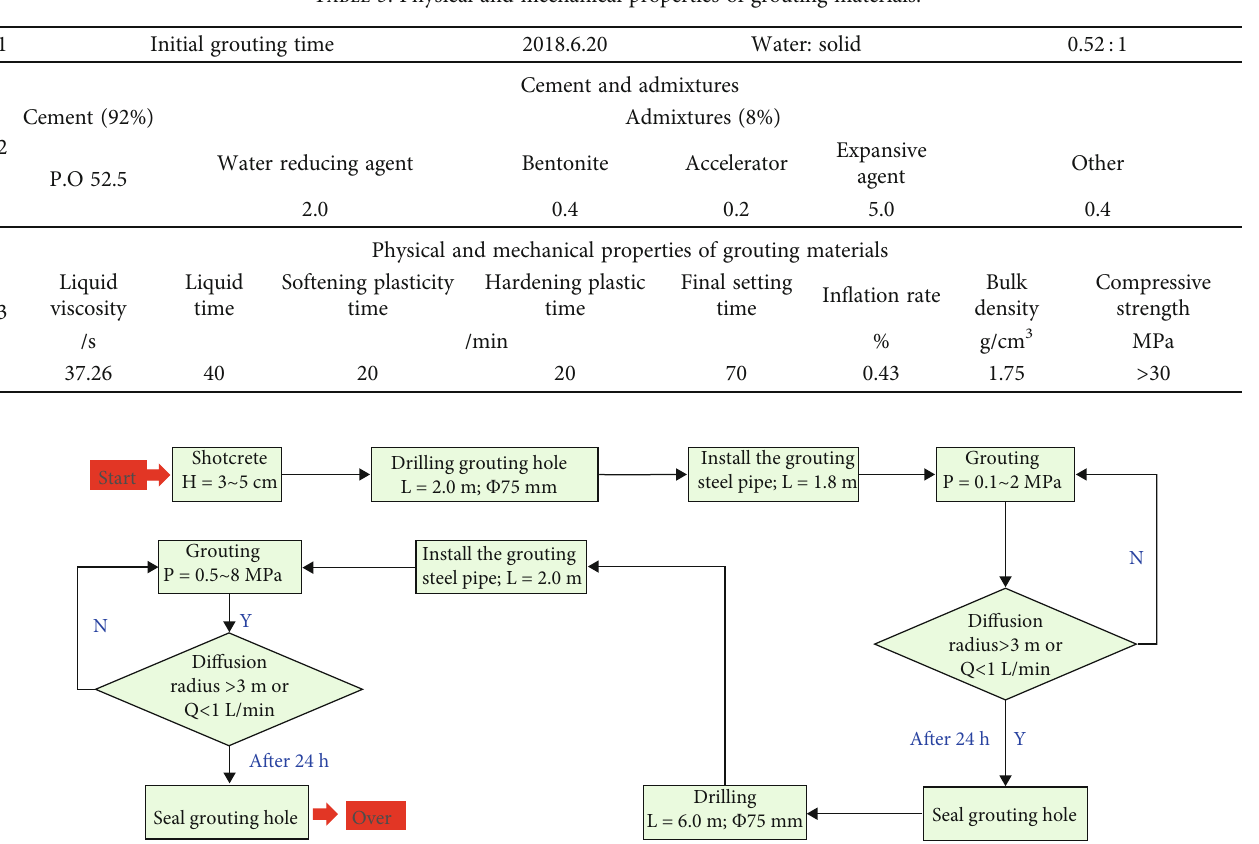
Figure 7: Double-shell grouting reinforcement mechanism. Table 5: Physical and mechanical properties of grouting materials.